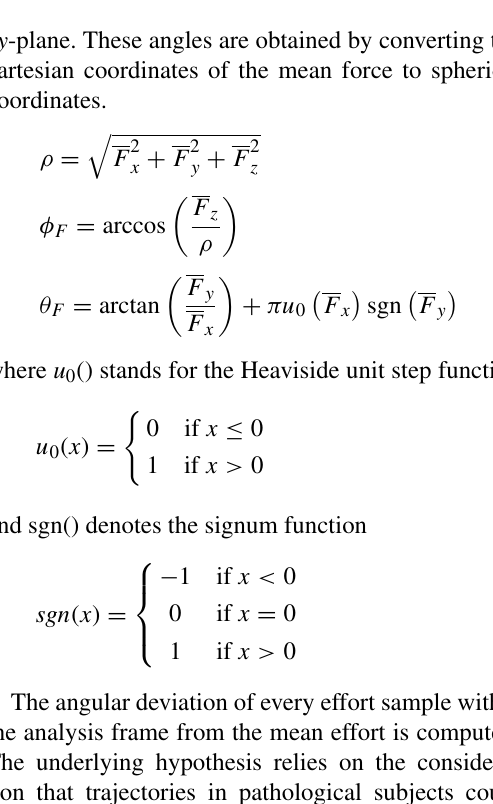
Fig. 5. Flowchart of the proposed method of force